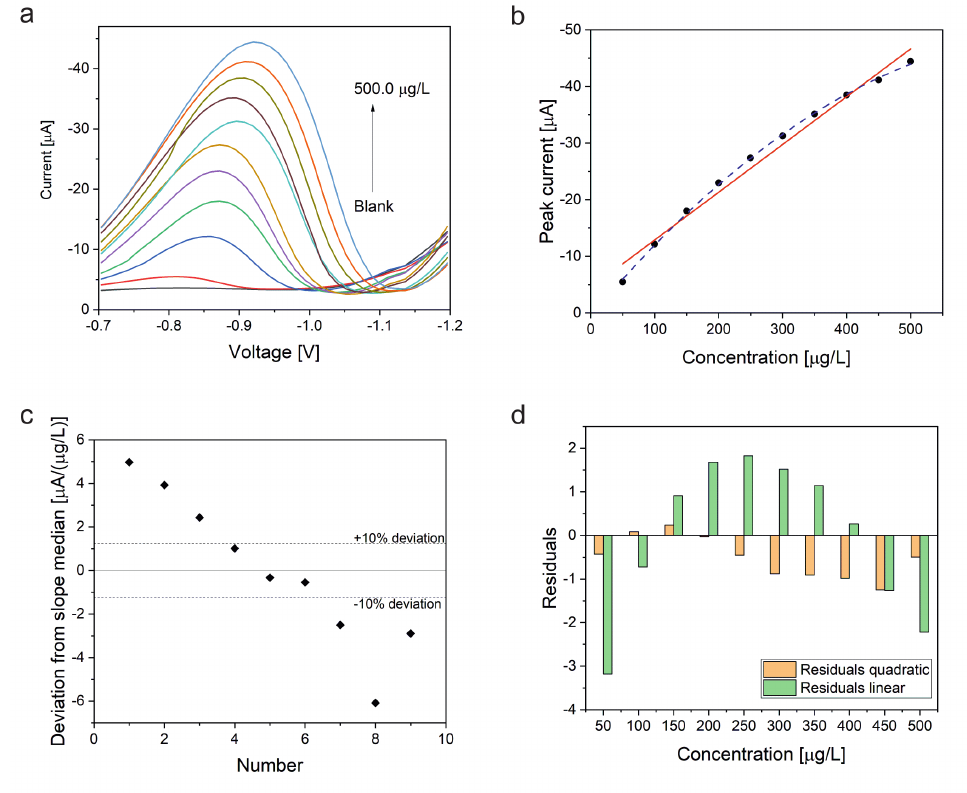
Figure 5. ( a ) Recorded voltammograms of different platinum standard solutions as measured on a bismuth film on screen-printed glassy carbon electrode. ( b ) Resulting calibration curve with linear (red solid line) and quadratic (blue dahed line) regression. ( c ) Results of the point-to-point gradient linearity test for the first order regression curve. ( d ) Plot of the residuals of the linear and quadratic regression,